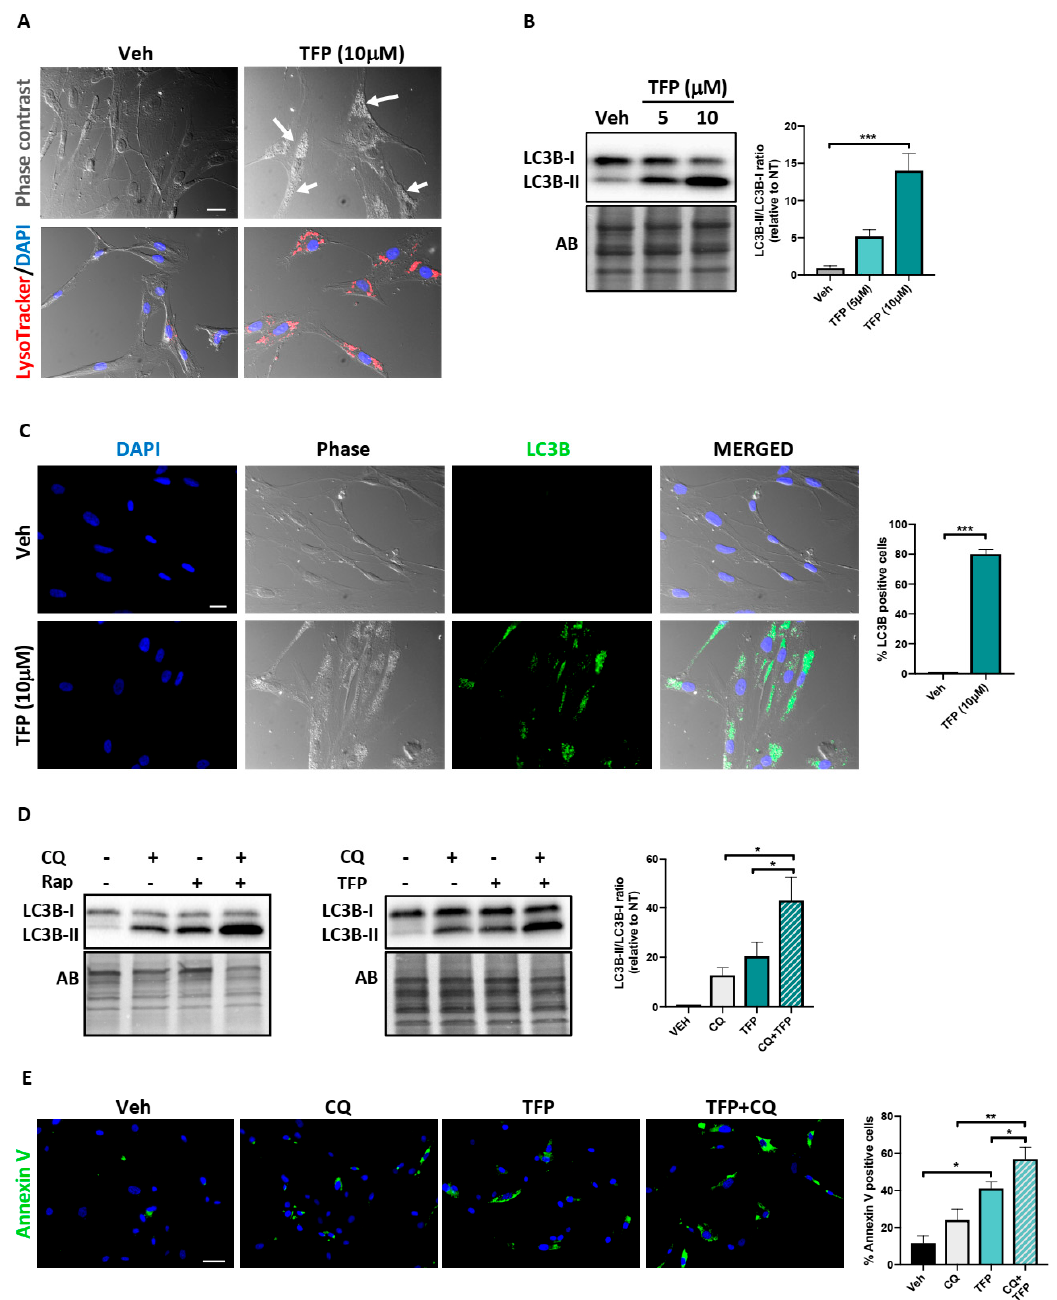
Figure 4. Induction of autophagy by trifluoperazine (TFP). ( A ) Bright-field images of PAH-PASMCs stained or not with LysoTracker Red after treatment or not with TFP (10 µ M) for 48 h. Nuclei were counterstained with DAPI (blue). Arrowheads indicate cytoplasmic vacuolization. ( B ) Representative Western blot and corresponding densitometric analyses of light chain 3 (LC3)B in PAH-PASMCs exposed or not to TFP for 48 h. ( C ) Representative immunofluorescence images and corresponding quantification of PAH-PASMCs labeled with LC3B after treatment or not with TFP (10 µ M). ( D ) Representative Western blot and corresponding densitometric analyses of LC3B in PAH-PASMCs exposed or not to rapamycin (Rap, 200 nM) or TFP (10 µ M) for 48 h in presence or not to chloroquine (CQ, 50 µ M) during the last 3 h. ( E ) Representative immunofluorescence images and corresponding quantification of apoptosis (as determined by Annexin V labeling) in PAH-PASMCs ( n = 3) pretreated or not with CQ (10 µ M) for 3 h before exposure or not to TFP (5 µ M) for 24 h. Experiments were performed on three different PAH-PASMC cell lines. Data are presented as mean ± SEM; * p < 0.05; ** p < 0.01 and *** p < 0.001. Scale bars: 20 µ m in A and C; 50 µ m in